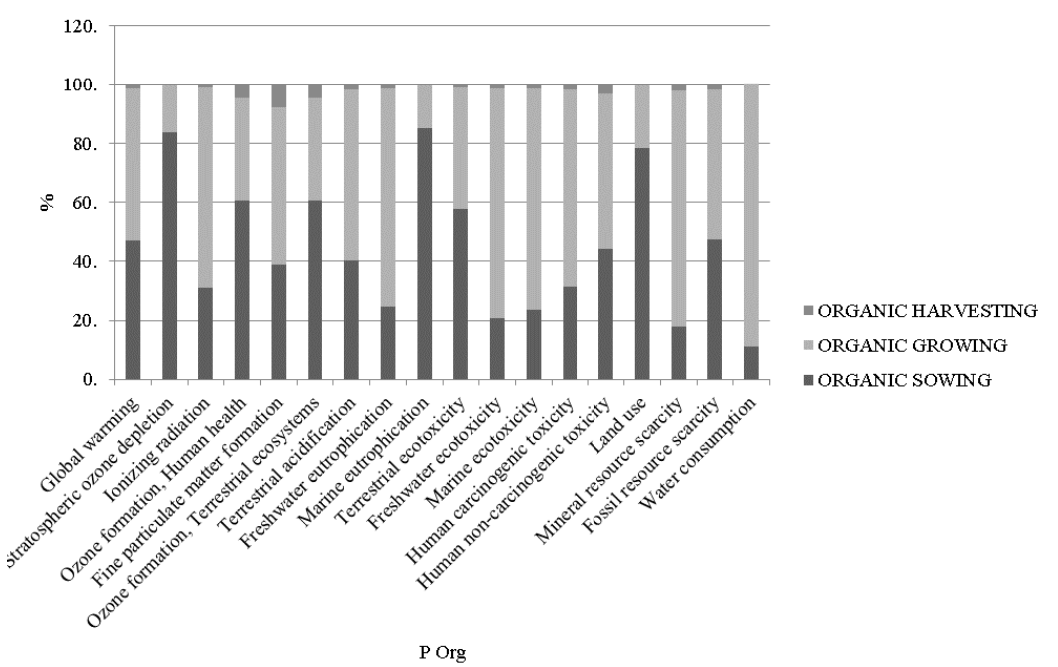
Figure 5. Environmental impact of early potato cultivation with organic method, per impact category and main cultivation operations.